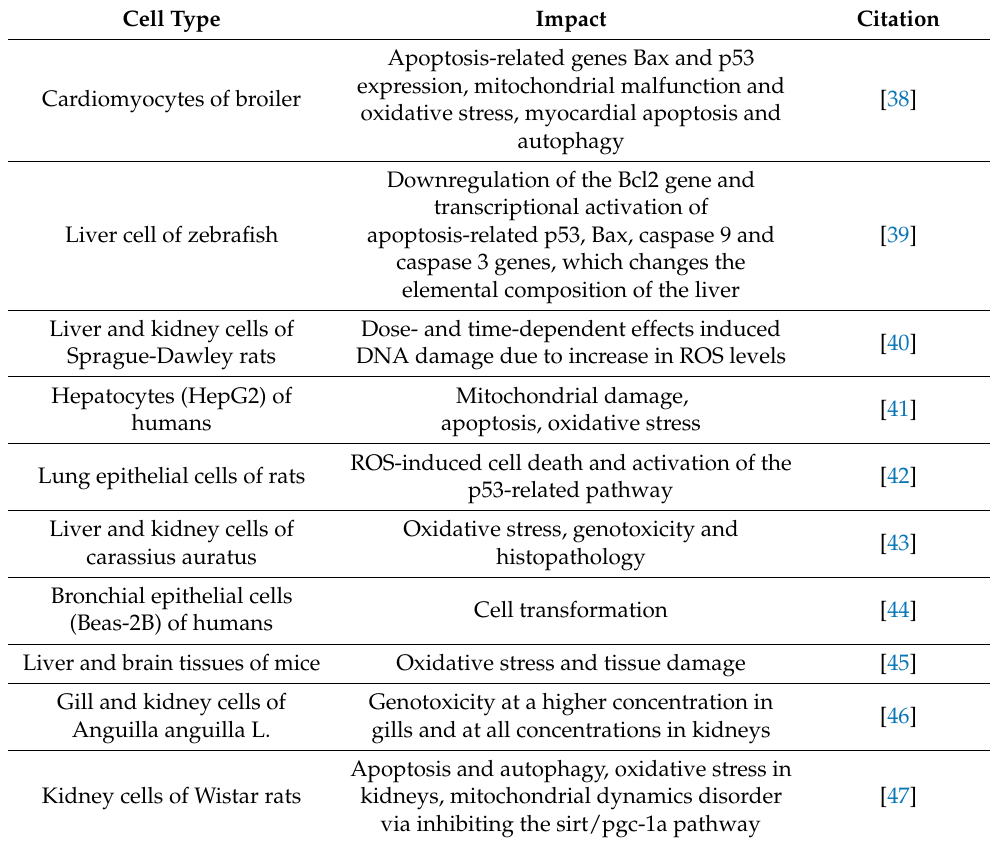
Table 1. Cr (VI)-induced ROS generation and their lethal